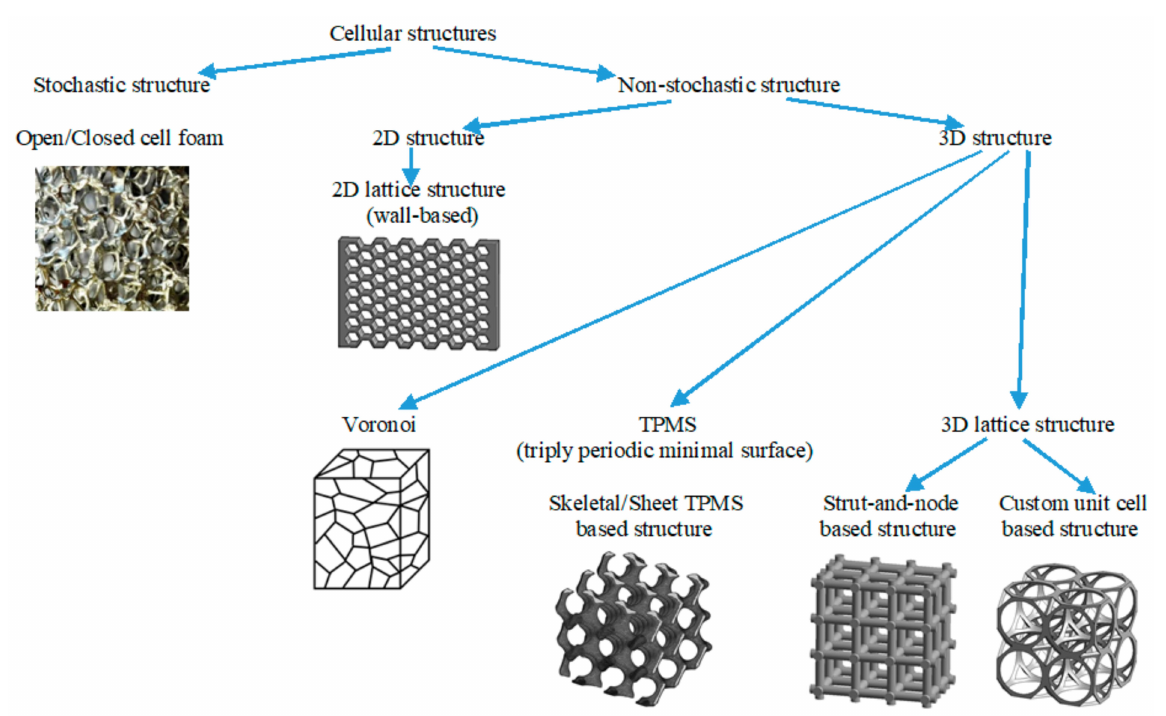
Figure 1. Categories of cellular